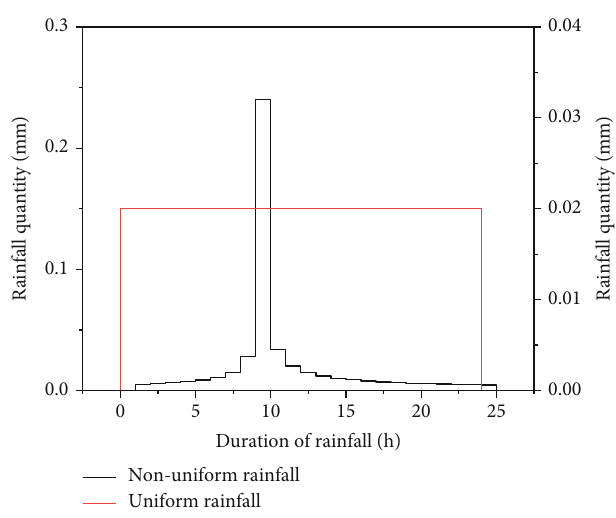
Figure 3: The uniform and nonuniform rainfall patterns analyzed in this